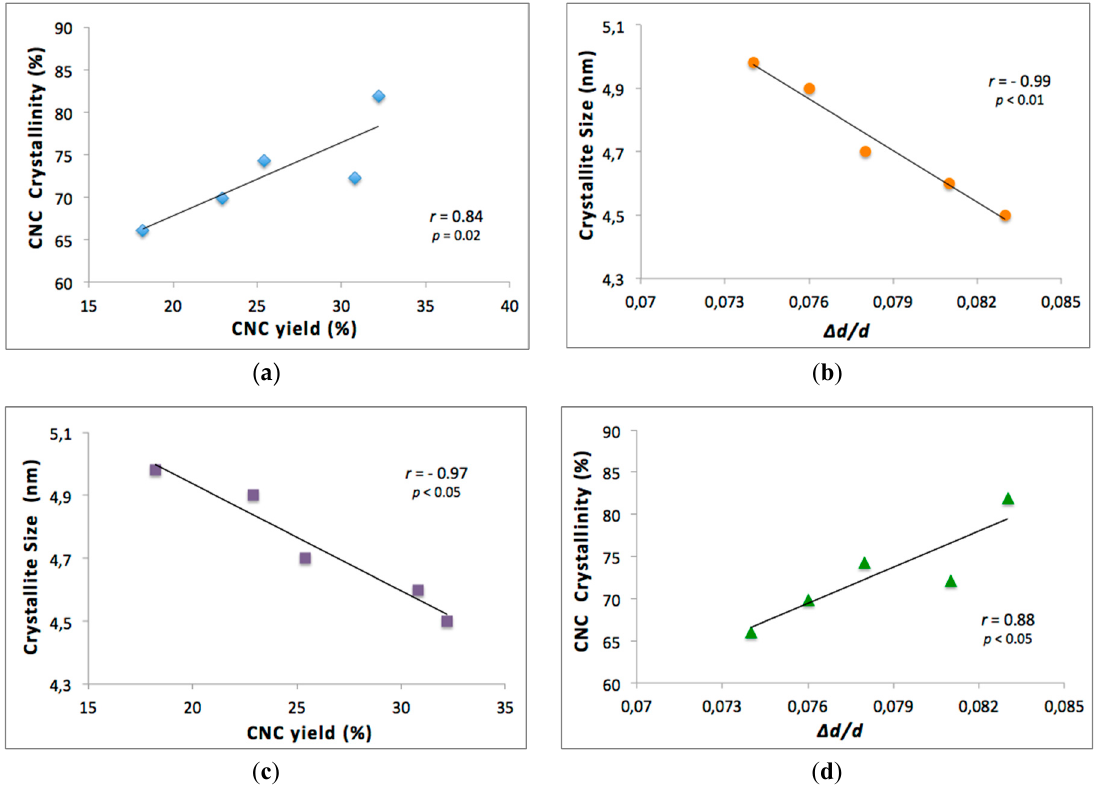
Figure 6. Regression lines and Pearson correlation between ( a ) CNC crystallinity vs. CNC yields; ( b ) Crystallite size vs. ∆ d / d ; ( c ) Crystallite size vs. CNC yield; ( d ) CNC Crystallinity vs. ∆ d / d . The maximum standard error for CNC yield is 0.4%.